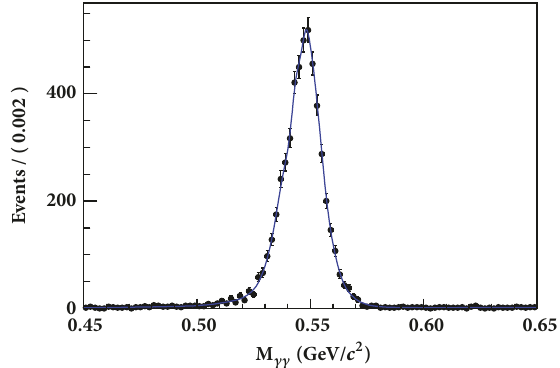
Figure 4: The 𝑀 𝛾 spectra of signal events from 𝐽/𝜓 󳨀→ 𝛾𝜂 MC 2 𝛾 3 sample(dotswitherrorbar)andtheshapeusedtofitthe 𝑀 𝛾 blue line). which is consistent with the input branching fraction 9.8 × 10 −4 .